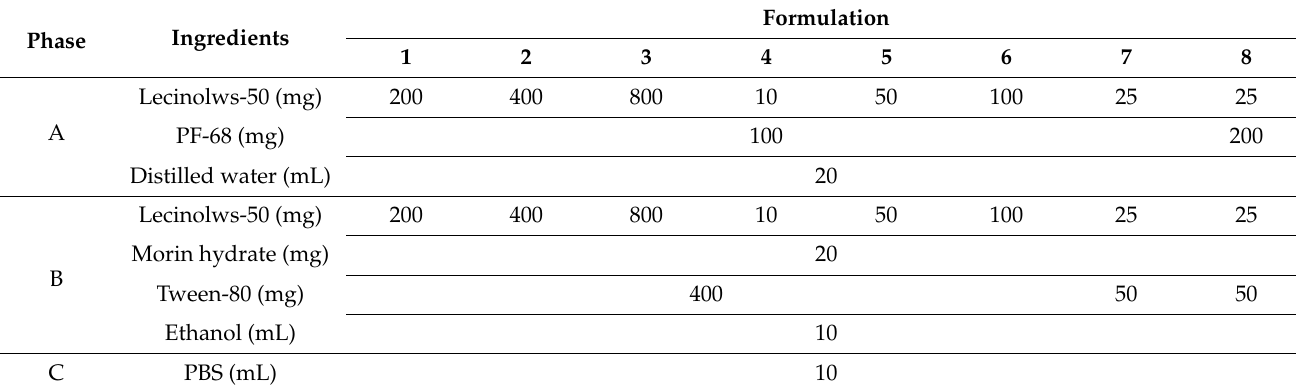
Table 1. Ingredients of liposomal